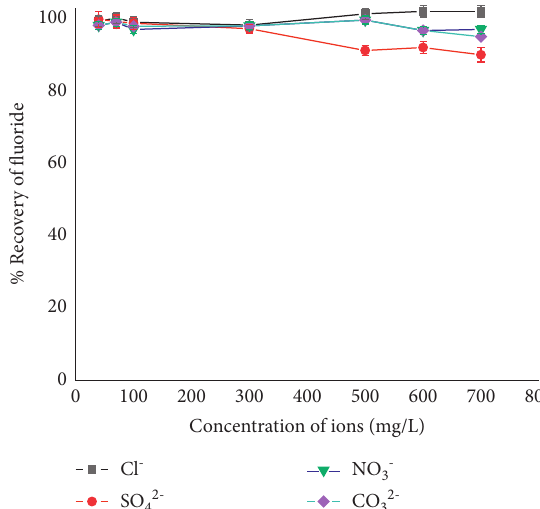
Figure 7: Effect of various amounts of interfering anions on 5.0 × 10 − 5 M Al-EBTcomplex plus 1.5mg/L fluoride at 544nm, with conditions of reaction time of 24h and pH 5.0.